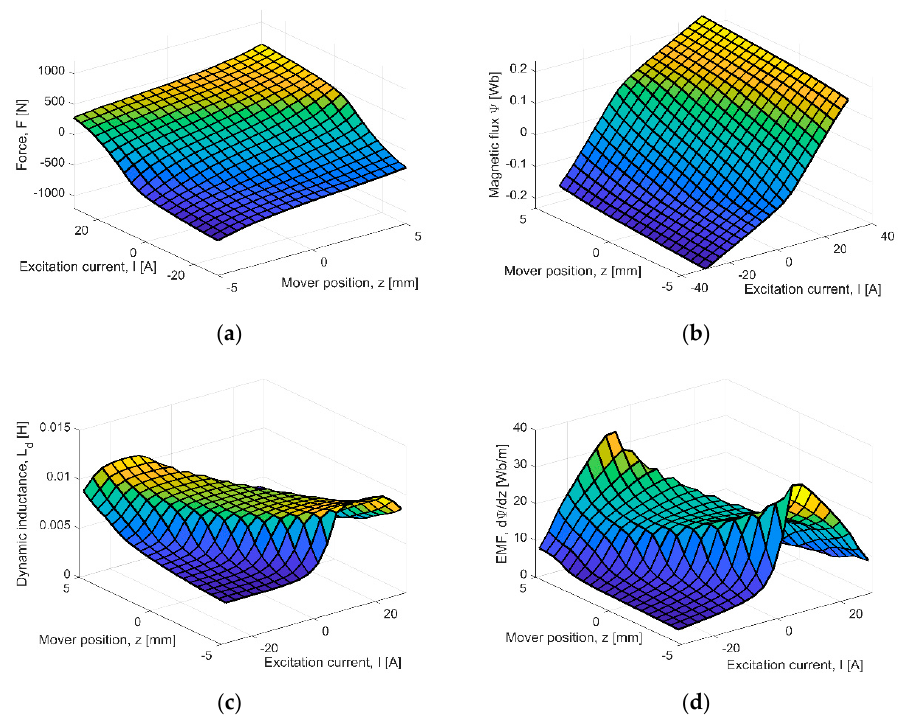
Figure 6. Integral parameters verso mover position z and excitation current value I : ( a ) thrust, ( b ) magnetic flux, ( c ) dynamic inductance, ( d ) electromotive force (EMF).